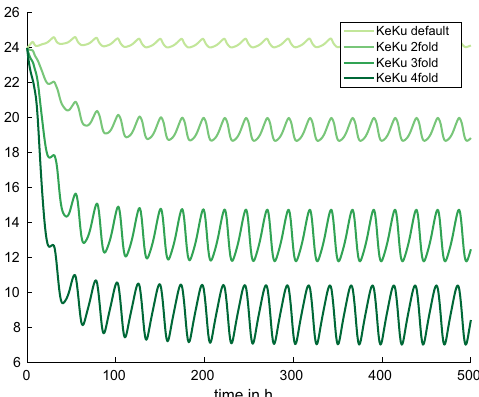
(a) The rate of potassium shift from extracellular space to urin, KeKu , is doubled compared to the default setting. K ECF and K ICF decrease rapidly at the beginning and than stabilize at lower values. The glucose concentration in blood, Gluc B , and insulin are not affected. Gluc B remains within its physiological range.